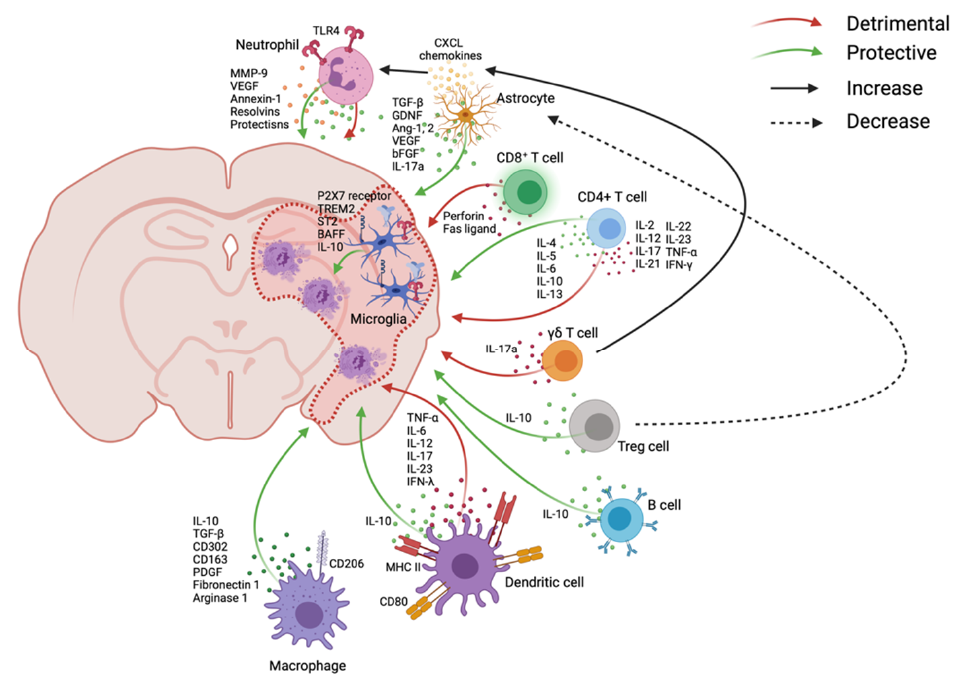
Figure 2. Schematic diagram of the immune responses in the later phase after stroke onset (created with BioRender.com).